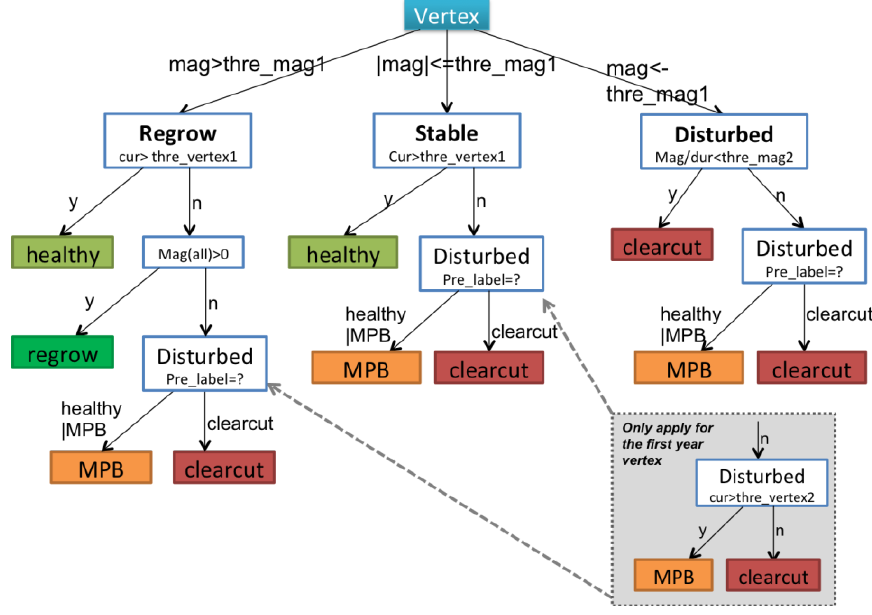
Figure 3. The decision tree used to attribute temporal segments into the different disturbance classes.